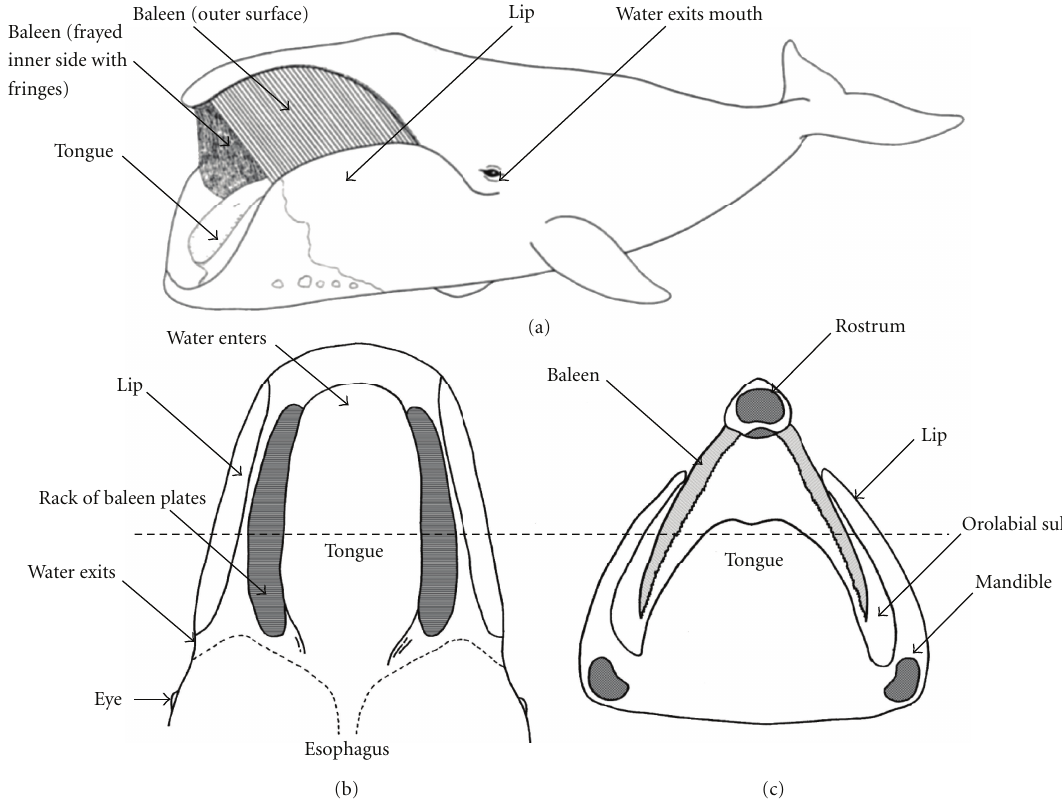
Figure 1: Schematic diagrams showing external (a) internal (b), and (c) morphology of the oral region and associated structures in a bowhead whale, Balaena mysticetus . At lower left (b) is a frontal section (anterior at top) and at lower right (c) a transverse section (dorsal at top), each at the level of the dashed horizontal line intersecting the other diagram. Prey-laden water enters the mouth anteriorly through a subrostral cleft (between baleen racks) and flows through and around the baleen plates and fringes, exiting, after prey have been removed, behind the